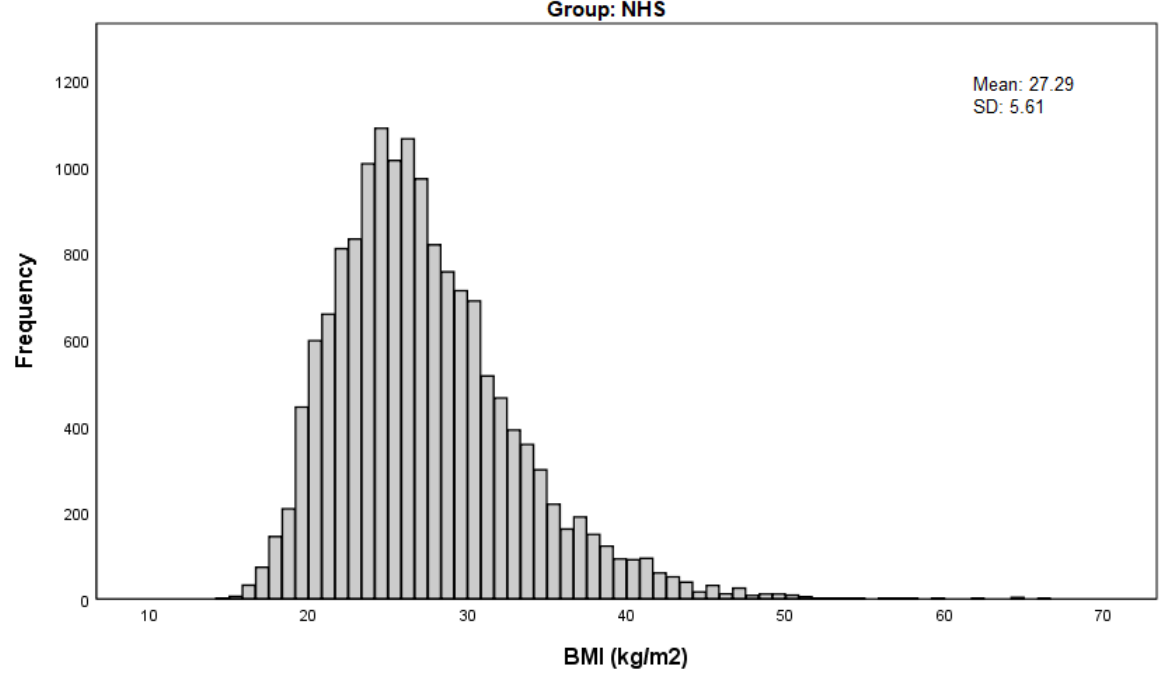
Figure 2. BMI distribution (kg/m2) of National Health Survey